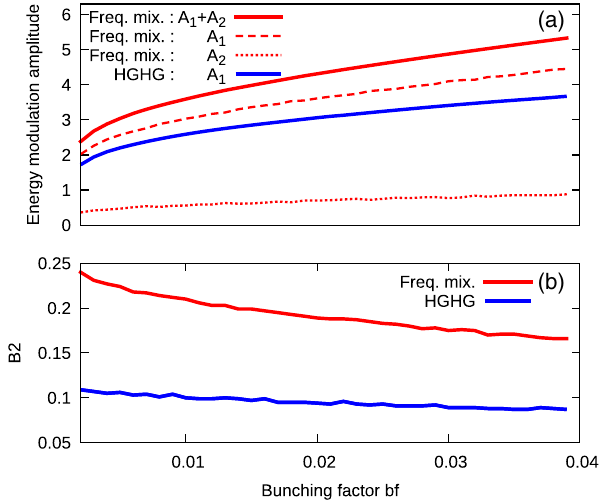
FIG. 6. (a) Minimum energy-spread modulation amplitude in function of the wanted bunching factor, for the HGHG scheme (blue line), and the frequency mixing scheme (Red lines, plain line: A 1 þ A 2 and dashed lines: details of A 1 and A 2 ). (b) Asso- ciated value of B 2 maximizing the bunching factor. Comparison done at 35.5 nm using Eq.